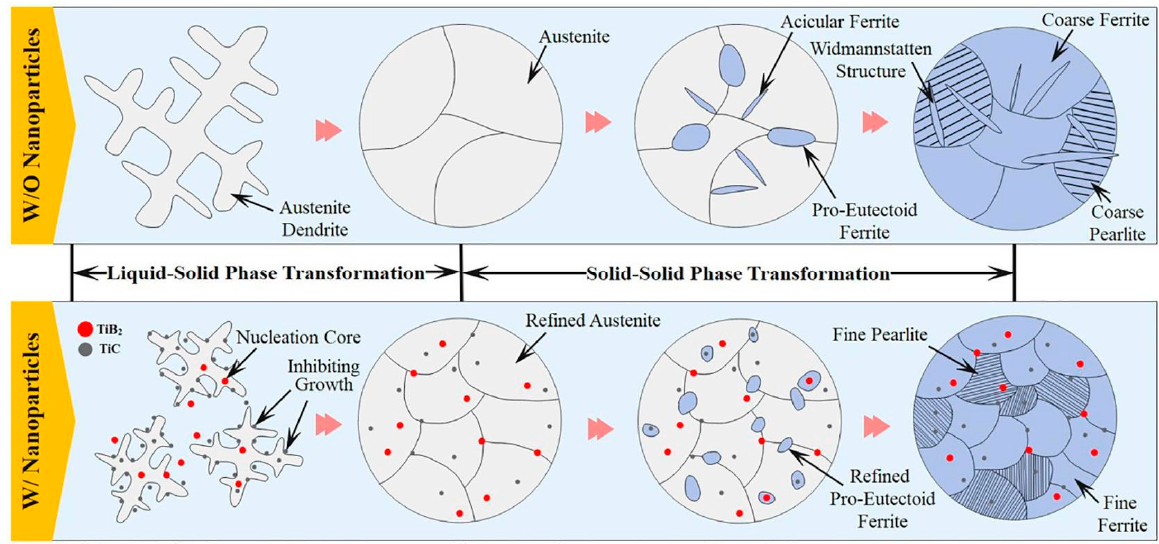
Figure 7. Microstructure refining mechanism by nanoparticles, reprinted with permission from ref. [116], 2022,